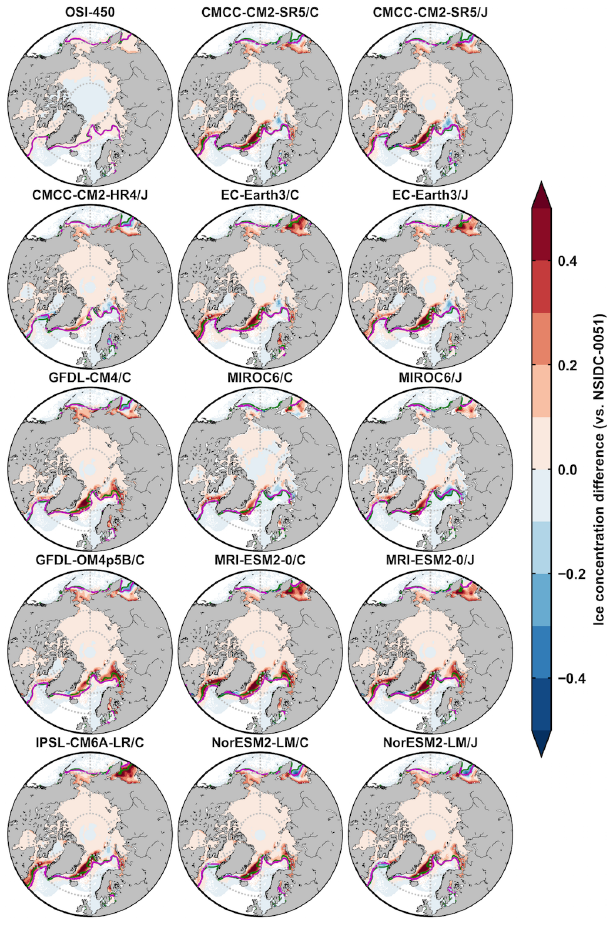
Figure A2. The 1980–2007 February mean Arctic ice concentration differences between OSI-450/model outputs and the NSIDC-0051 data (colors), and contours of 15% concentration of the NSIDC- 0051 data (green lines) and OSI-450/model outputs (magenta lines). The second and third columns are from the five OMIP1 and OMIP2 model outputs of CMCC-CM2-SR5, EC-Earth3, MIROC6, MRI- ESM2-0, and NorESM2-LM,